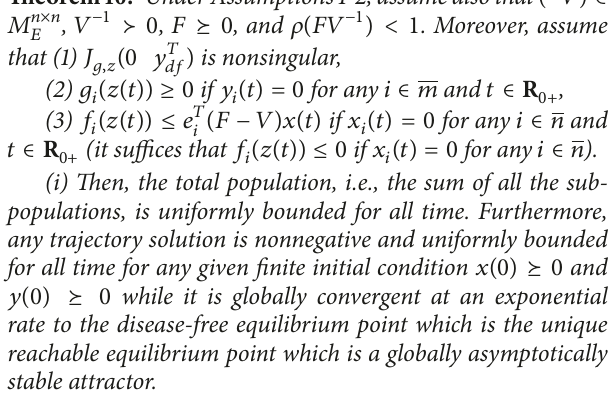
stable if 𝑅 0 ≥ 1 . Note also that Proposition 7 agrees with the conclusions of Examples